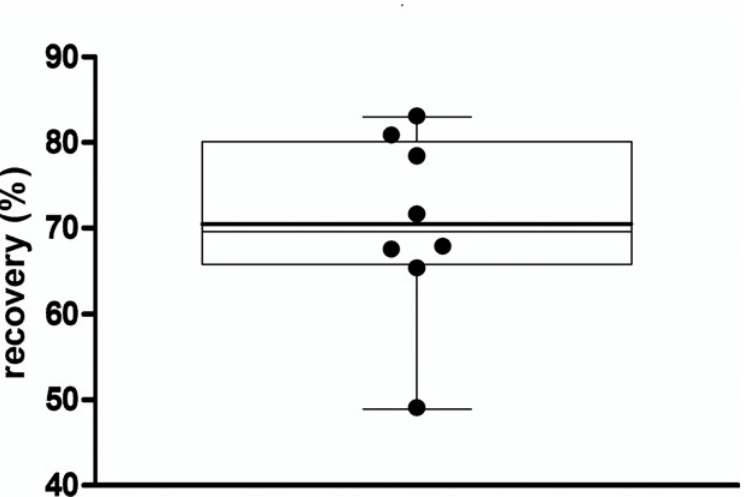
Fig 5. Spike and recovery. Eight native plasmas were spiked with 5 ng/ml alpha-synuclein, recoveries are illustrated in a box plot * , mean recovery was 70.4%. * The boxes upper and lower borders represent the 25th and 75th percentile, whiskers indicate the 10 to 90 percentile, lines within the box mark the median (thin line) and the mean (bold